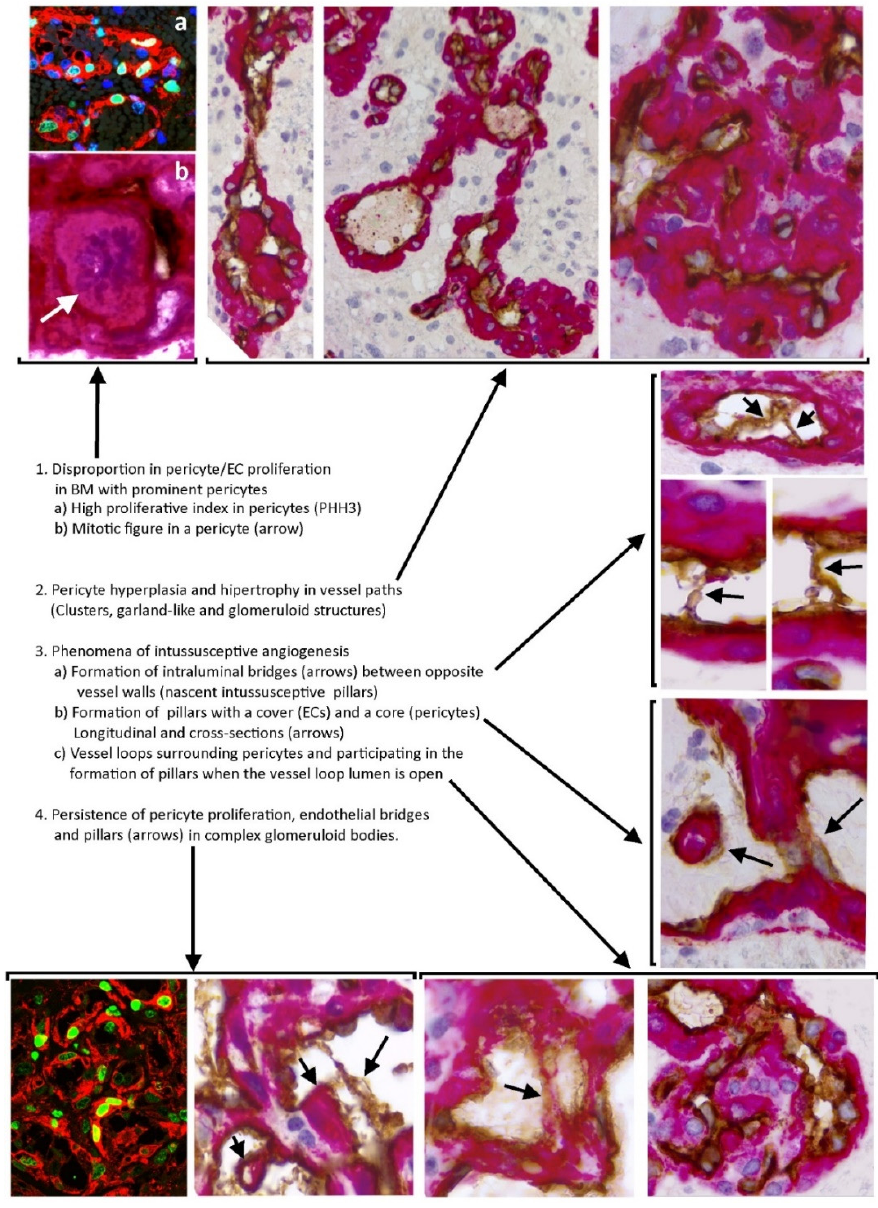
Figure 9. Summary with images of the mechanisms involved in bizarre microvasculature formation in